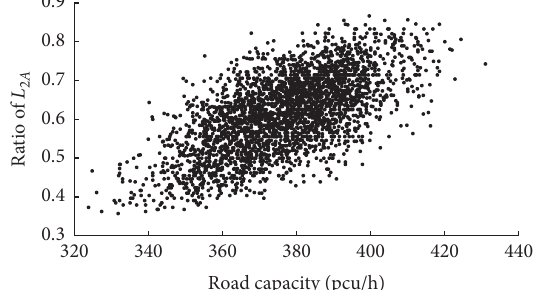
Figure 4: Relationship between road capacity and length of road section L capacity 2 A